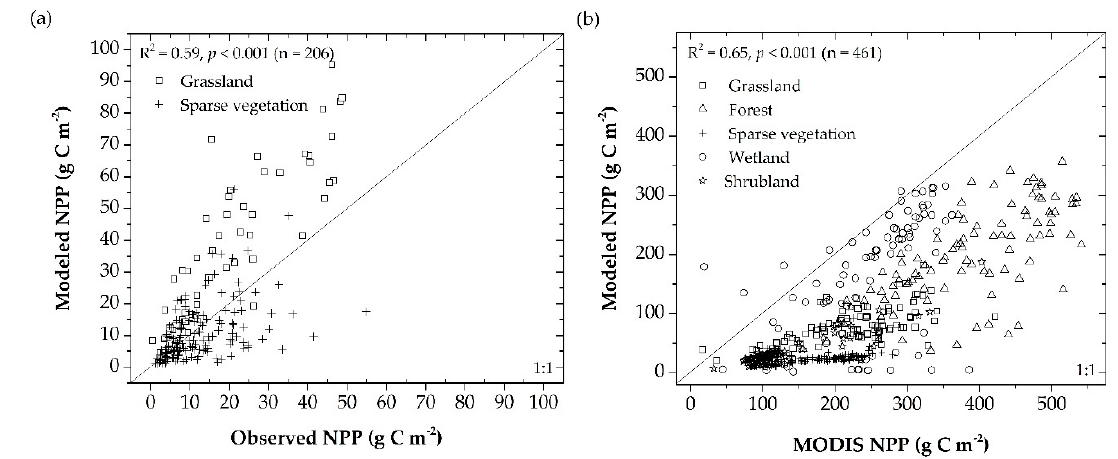
Figure 3. ( a ) Comparisons between daily observed Net Primary Production (NPP) and BEPS-simulated NPP. ( b ) Comparisons of annual MODIS NPP and BEPS-simulated NPP. Symbols represent the mean NPP values from 2003 to 2018 by land cover types.